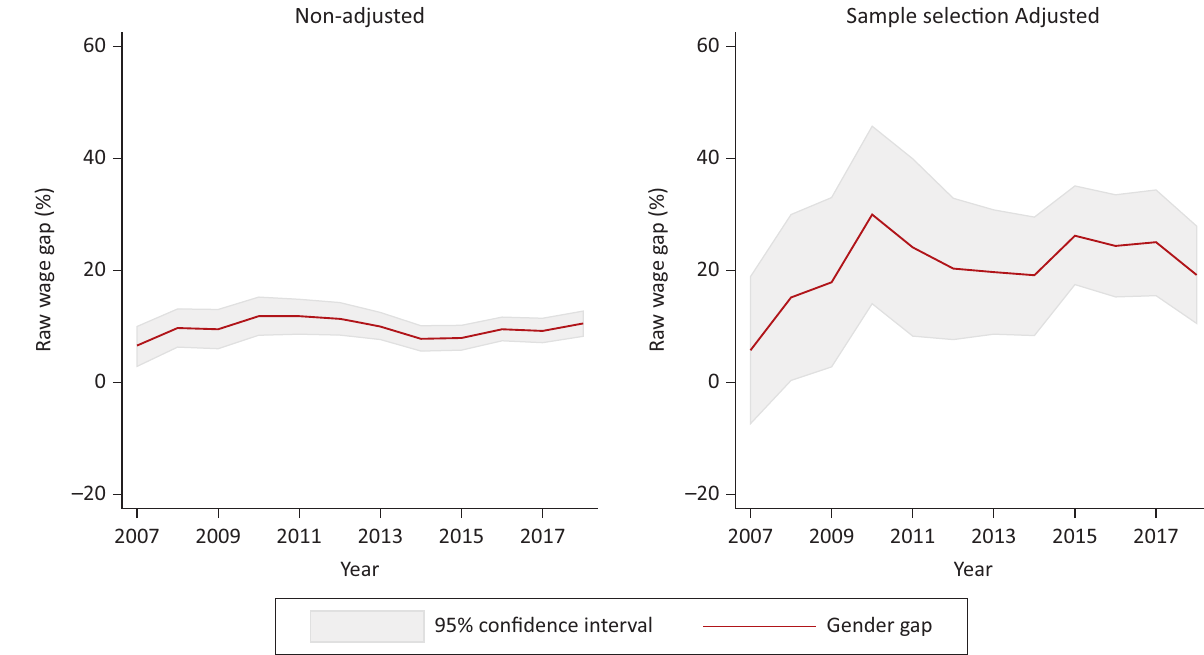
Figure 2. Raw wage gap vs. raw wage adjusted by sample selection. Notes: The dependent variable is measured as the ln(hourly wage) in the main occupation; first‐step Heckman estimations include as instruments: number of children under six years of age, children between six and 17 years of age, marital status, other household member’s income, and head of